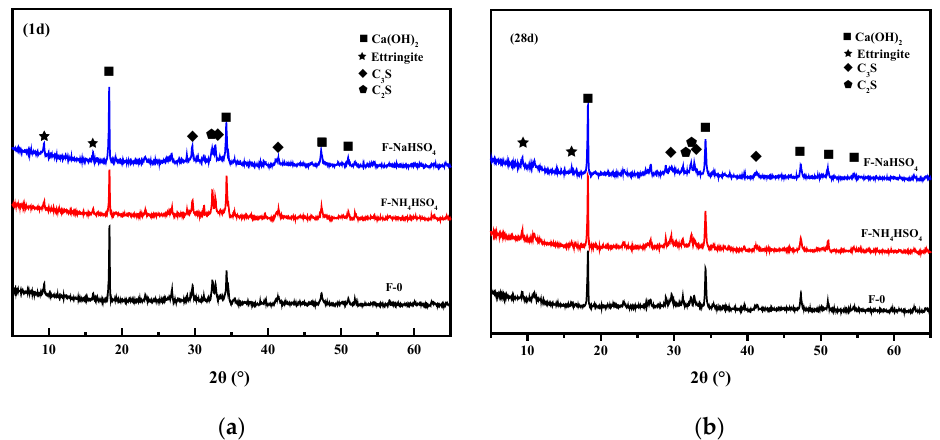
Figure 6. XRD patterns of the hydration products of the cement fly ash paste after ( a ) 1 day and ( b ) 28 days.